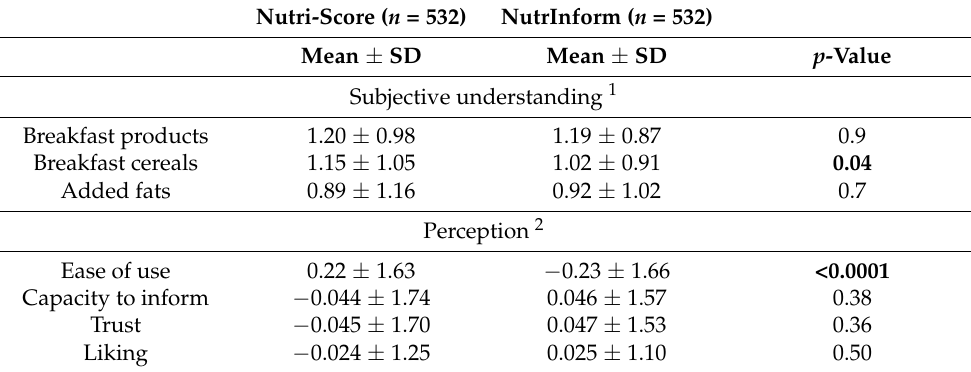
Table 2. Results of subjective understanding by food category and overall perception ( n =1064).